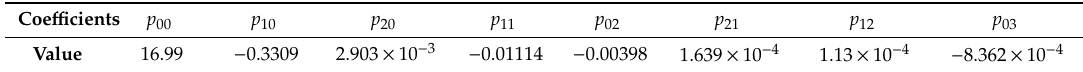
Table 2. Identification of coefficients of the model.